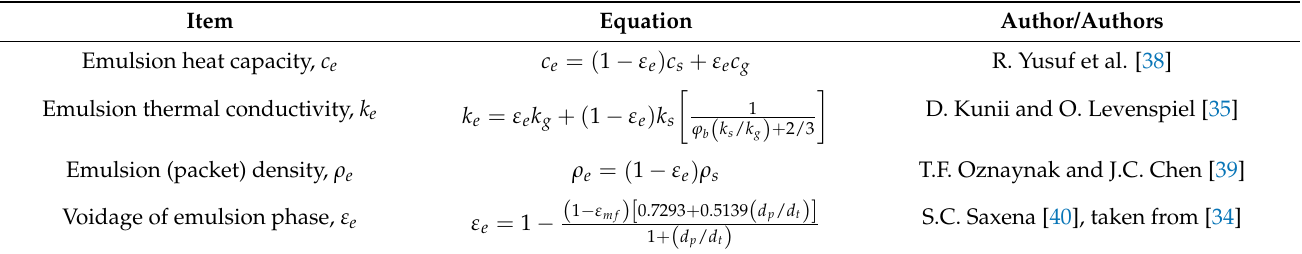
Table 1. The correlations used to determine physical properties of emulsion.